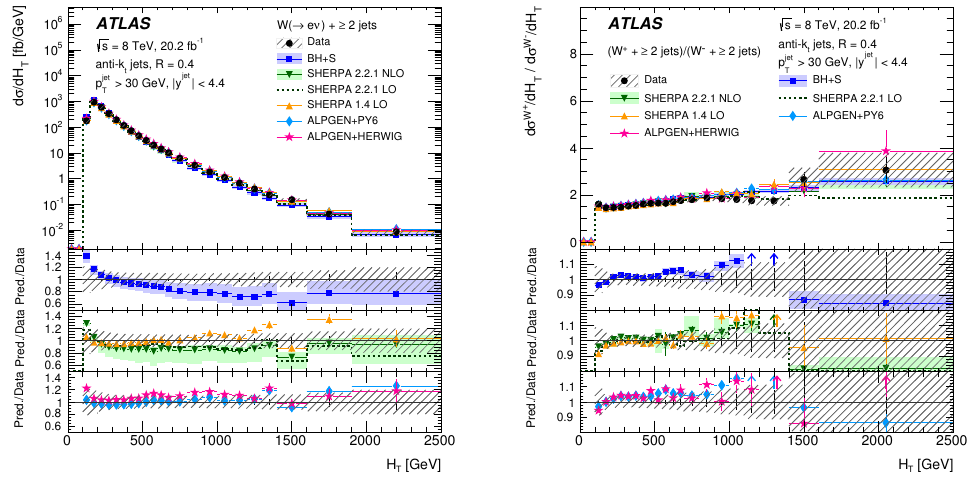
Figure 11 . Di(cid:11)erential cross sections for the production of W bosons (left) and the W + =W (cid:0) ratio (right) as a function of the H T for events with N jets (cid:21) 2. The last bin in the left (cid:12)gure includes values beyond the shown range. For the data, the statistical uncertainties are indicated as vertical bars, and the combined statistical and systematic uncertainties are shown by the hatched bands. The uppermost panel in each plot shows the di(cid:11)erential cross sections, while the lower panels show the ratios of the predictions to the data. The theoretical uncertainties on the predictions are described in the text. The arrows on the lower panels indicate points that are outside the displayed